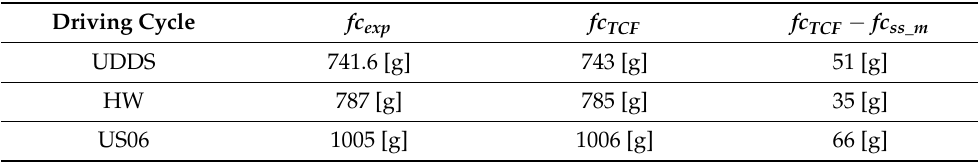
Table 4. Comparison of total fuel consumption calculated from the model and measured from the